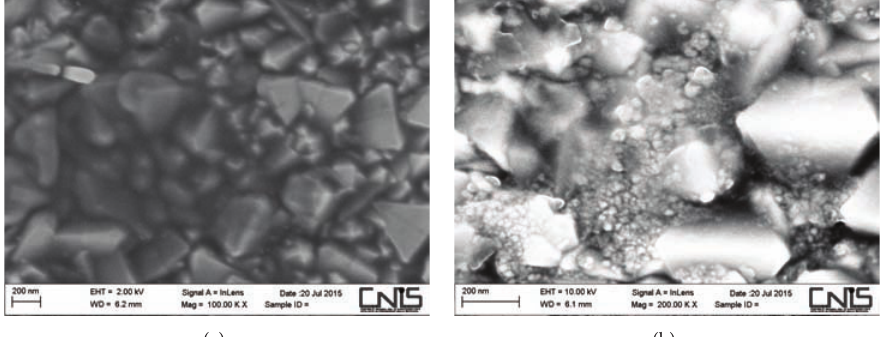
Figure3:SEMpicturesof(a)pristineITOand(b)electrochemicallycycledITOafterthestabilizationofthevoltammogram(cathodicprocess of Figure